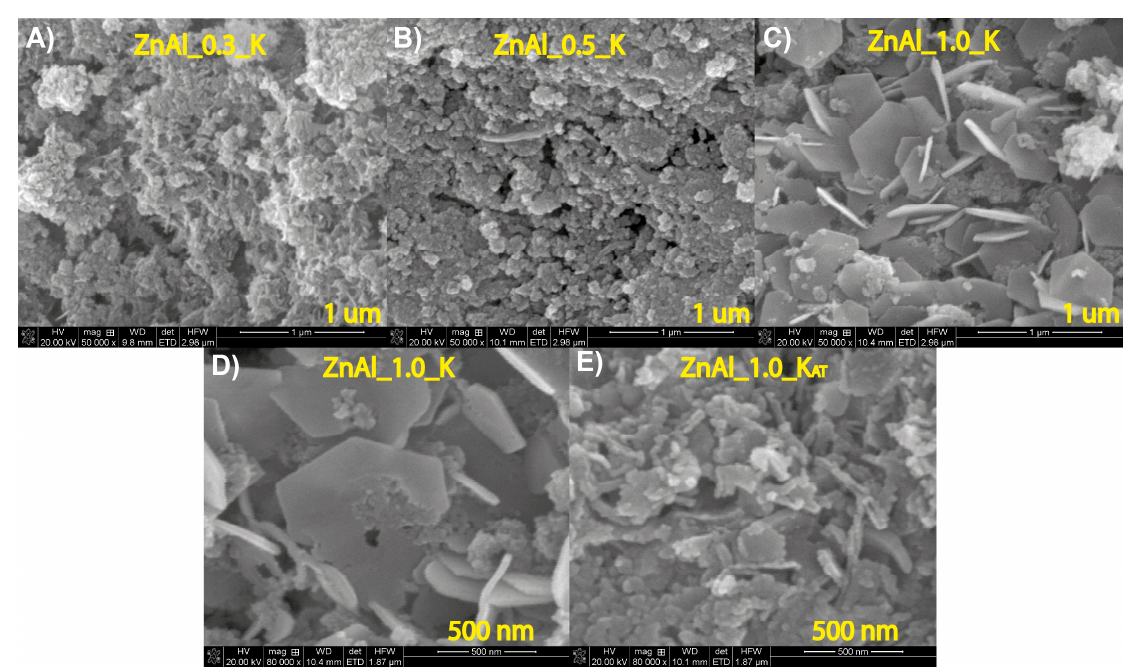
Figure 6. SEM images of the ZnAl_X_K ( A ) ZnAl_0.3_K, ( B ) ZnAl_0.5_K, ( C ) ZnAl_1.0_K, ( D